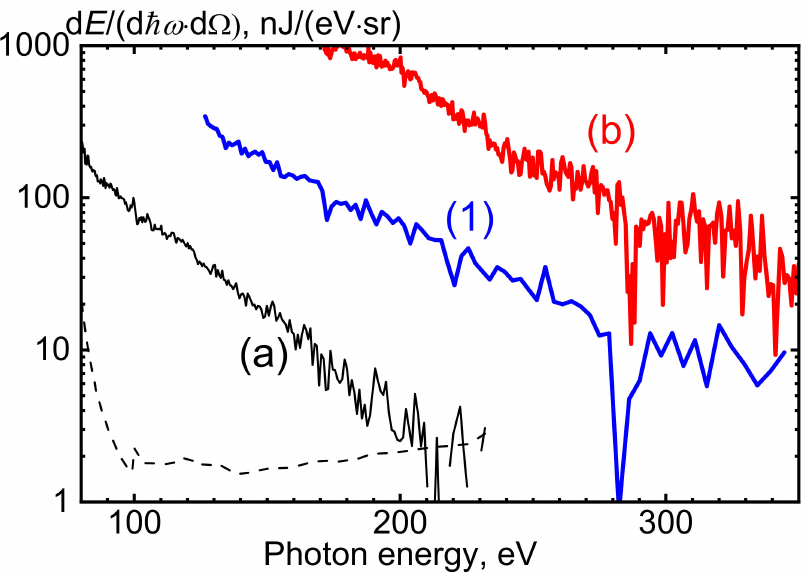
Figure 3. The strongest X-ray spectra obtained in each of the experimental campaigns performed with the same laser (J-KAREN). Curves (a) and (b) are obtained in the experimental campaigns with the spots shown in Figure 2a,b, respectively. Curve (1) is the spectrum shown in Figure 2d of [1]. The dashed curve is the estimated noise level for Curve